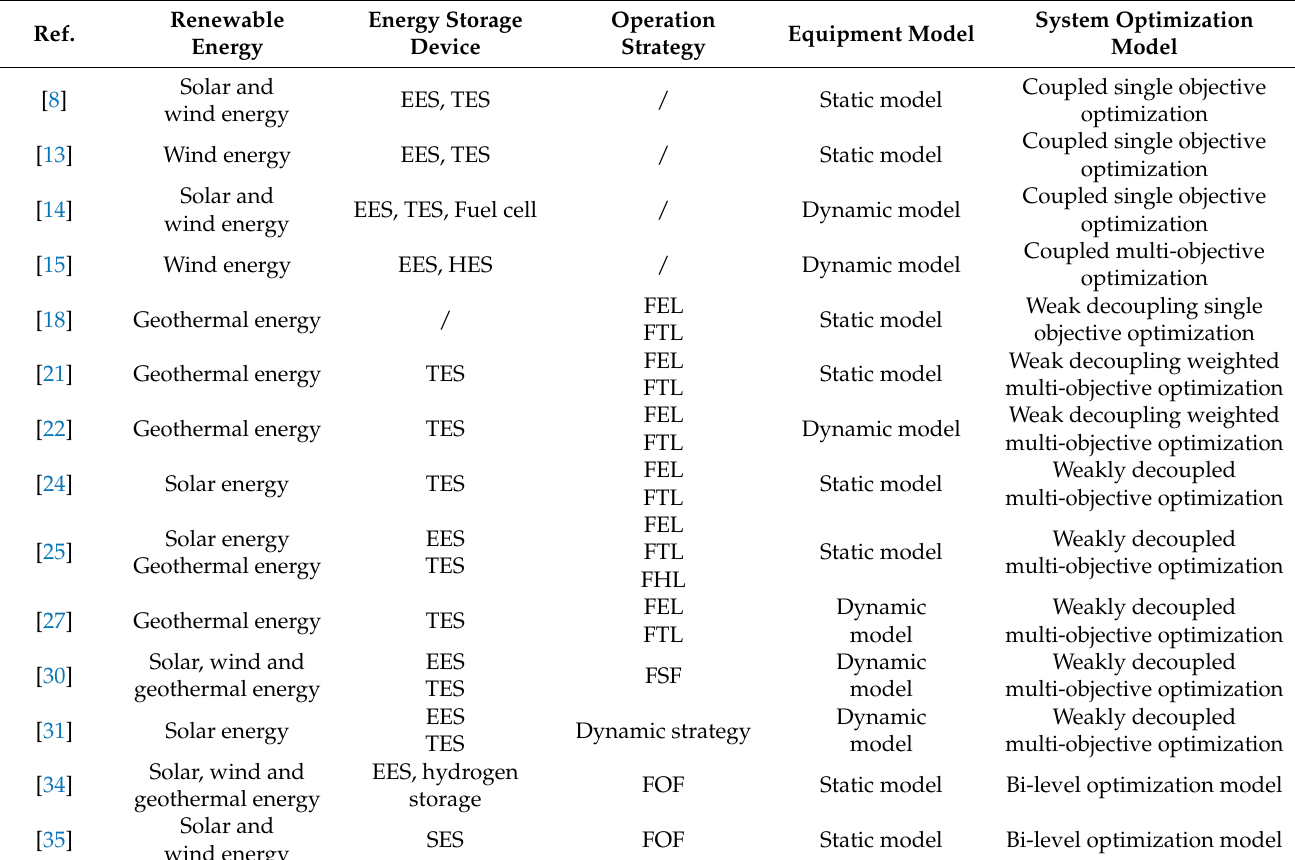
Table 1. Literature review of the integrated energy system with energy